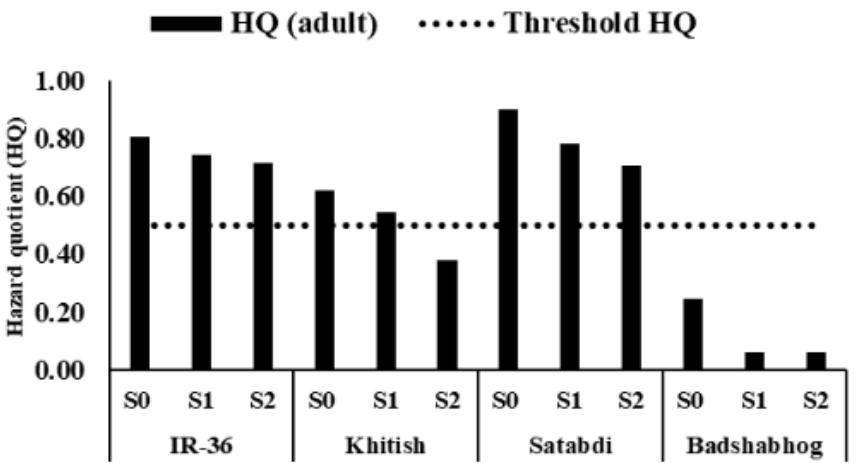
Figure 4. Hazard quotient values for arsenic in different rice cultivars under silicate treatments (sodium metasilicate (Na 2 SiO 3 ) was added to the soils in pot at the rates of 0 (S0), 250 (S1), and 500 (S2) mg kg −1 soil).